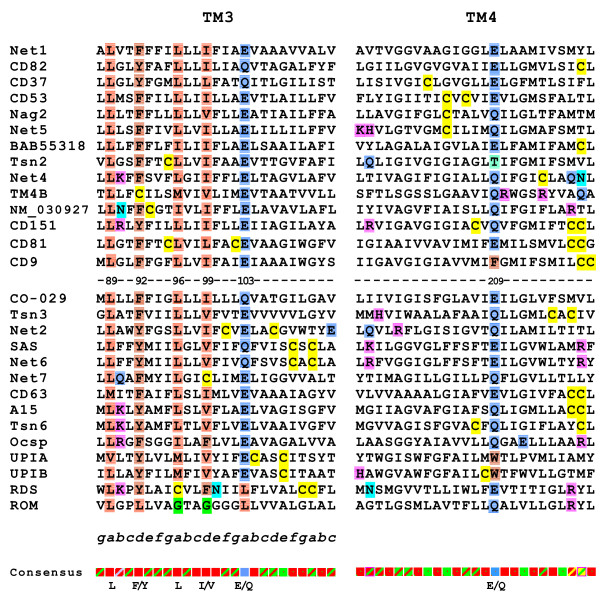
Sequence alignment of the transmembrane domains 3 and 4 of 28 human tetraspanins. Residues from heptad positions a and d in TM3 are highlighted. Also highlighted are the conserved Glu/Gln residue in TM4, other polar residues and cysteines. The color scheme is as in Figure 1.